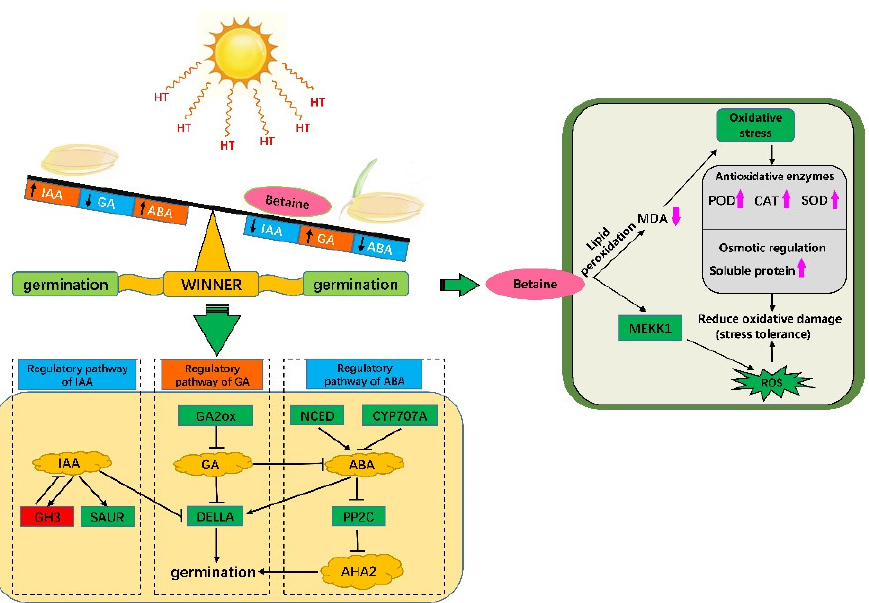
Figure 9. Regulatory pathways of 10 mM exogenous betaine enhance the protrusion vigor of rice seeds under heat stress.